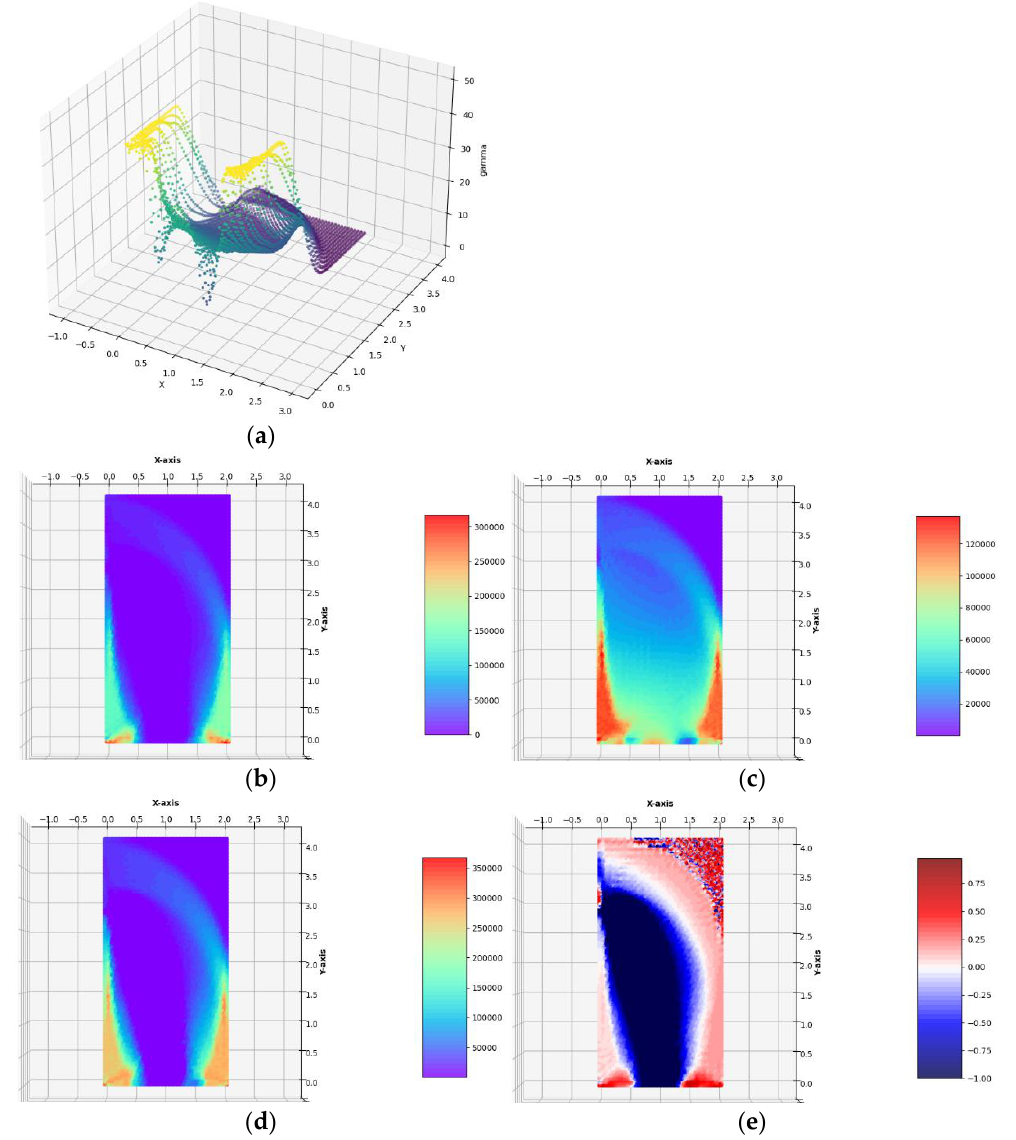
Figure 8. Optimal solutions for the Example 1b. ( a ) The plot of the γ function, ( b ) bulk modulus k * / b , ( c ) shear modulus µ * / b , ( d ) Young’s modulus E * / b , ( e ) Poisson’s ratio ν * in the case of FEM mesh composed of triangular elements.